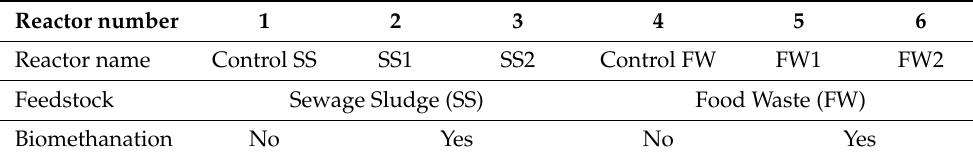
Table 2. Reactor conditions during biomethanation